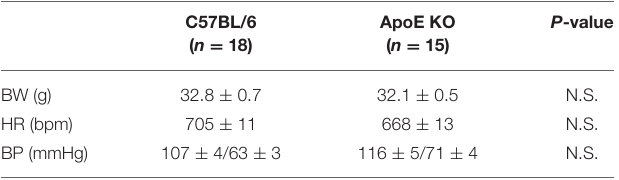
TABLE 1 | Body weight, heart rate, and blood pressure of the C57BL/6 and ApoE KO mice. C57BL/6 ( n =